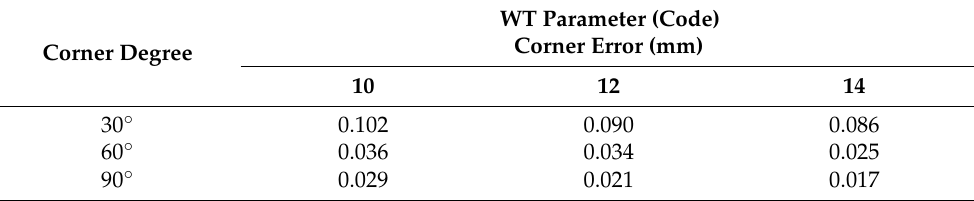
Table 10. Wire tension (WT) vs. corner error.